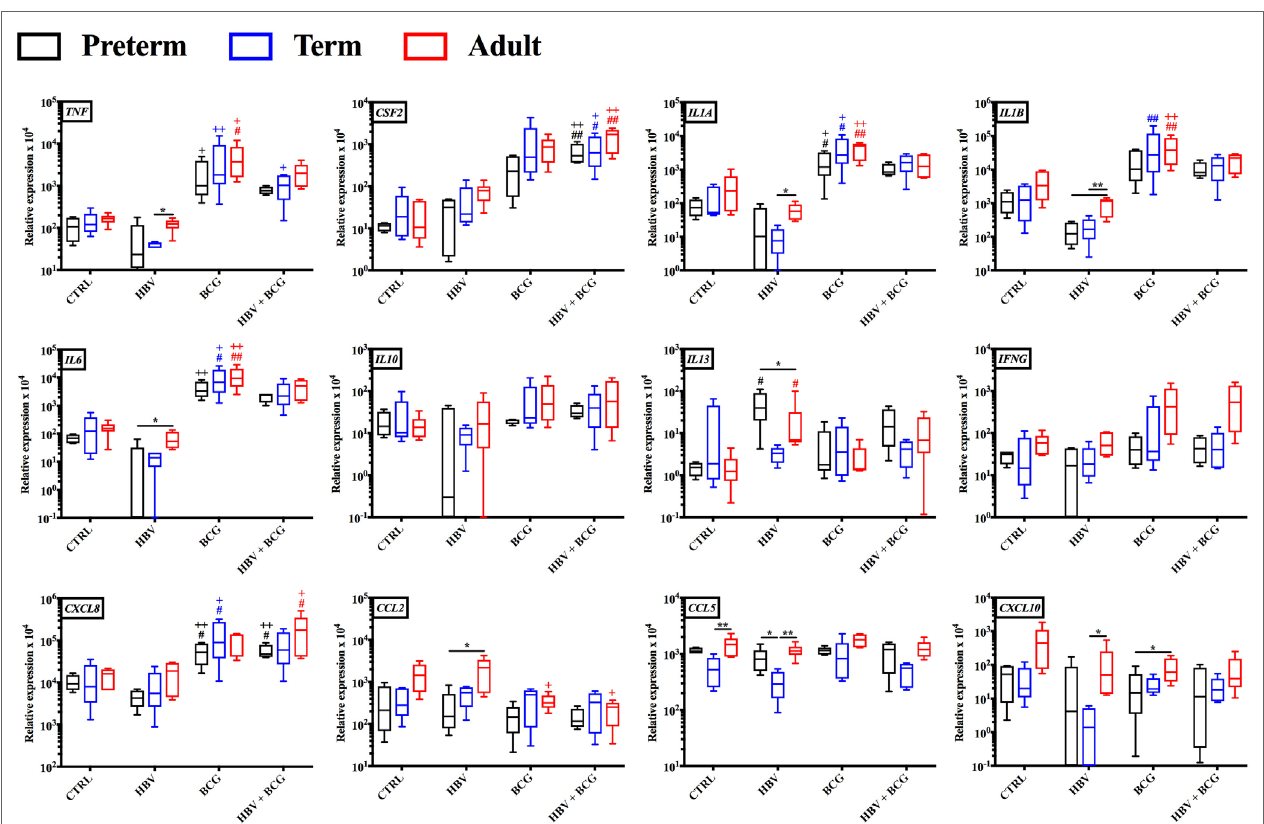
FigUre 3 | Gene expression profiles induced by hepatitis B vaccine (HBV) and Bacille Calmette–Guérin (BCG) in human preterm, term, and adult mononuclear cells. Preterm and term cord blood mononuclear cells, and adult peripheral blood mononuclear cells was stimulated for 4 h with either HBV, BCG or (BCG + HBV) and cells were harvested for quantitative real-time PCR analysis. Statistical significance was determined by repeated measure or ordinary one-way ANOVA with Holm-Sidak post hoc test (or their non-parametric equivalent Friedman or Kruskal–Wallis with Dunn post hoc test). * p < 0.05, ** p < 0.01 of preterm vs. term vs. adult; #, + p < 0.05, ##, ++ p < 0.01 of groups indicated by the corresponding color, respectively, vs. saline or HBV. N =